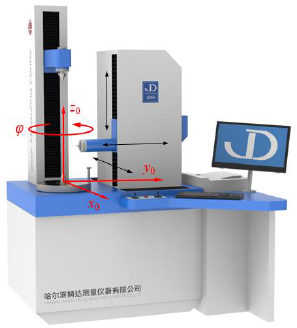
Figure 5. Measurement instrument.